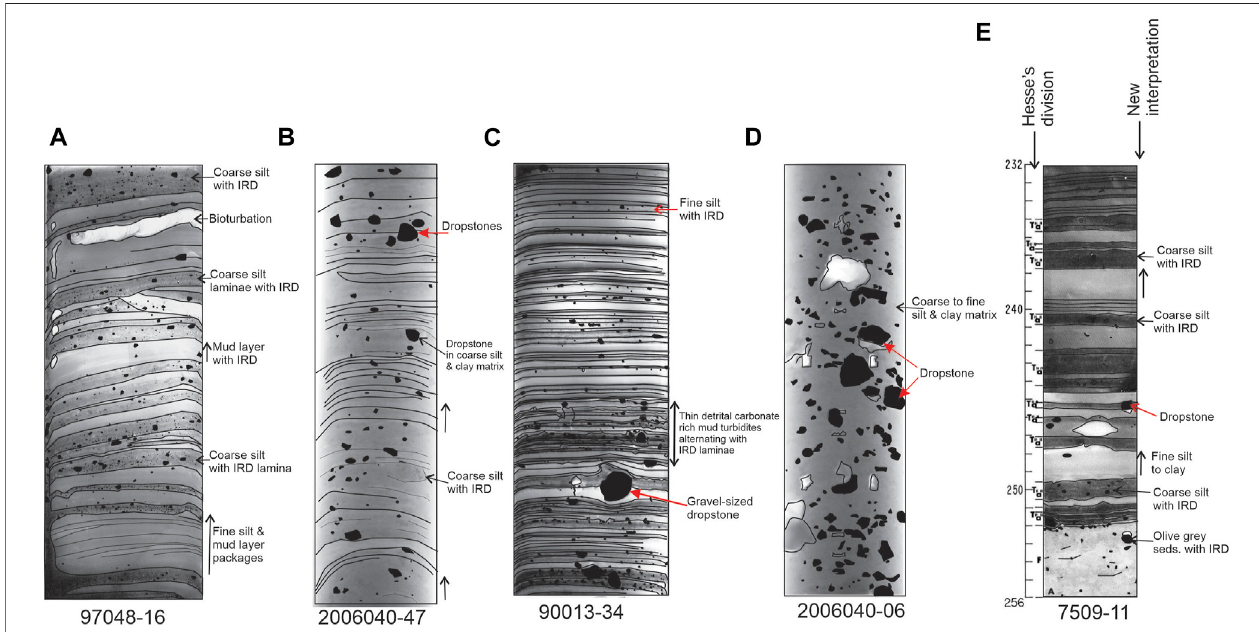
FIGURE 7 | Sedimentary structures derived from the X-radiographs highlight the differences between H3 and other H layers in the Labrador Sea. (A) Core Hu97048-16 (H1) shows graded fi ne silt and mud layers, coarse silt with IRD lamina, and mud layers with occasional IRD or dropstones; (B) core Hu2006040-47 (H3) showsdropstonesincoarsesiltandclaymatrix,coarsesiltinterspersedwithIRDwiththeprogressivedisappearanceofcoarsesiltwithIRDlaminae; (C) core90 – 34(H3; 255 – 275 cm)showsthindetritalcarbonatesrichmudturbiditesalternatingwithIRDlaminae, fi nesiltwithIRDandoccasionalgravel-sizeddropstones;and (D) core Hu2006040-06 (see also Figure 5 ) shows gravel to pebble-sized dropstones in fi ne silt and clay matrix. (E) reinterpretation of Ta division ofturbidite (Hesse et al., 1987) intocoarse(dark)siltwithIRD,pebble-sizeddropstoneswithintheIRDlaminae,andmudlayerofcoreHu75-11(H2layer)retrievedfromtheleftleveeoftheNAMOC( see Figure 1